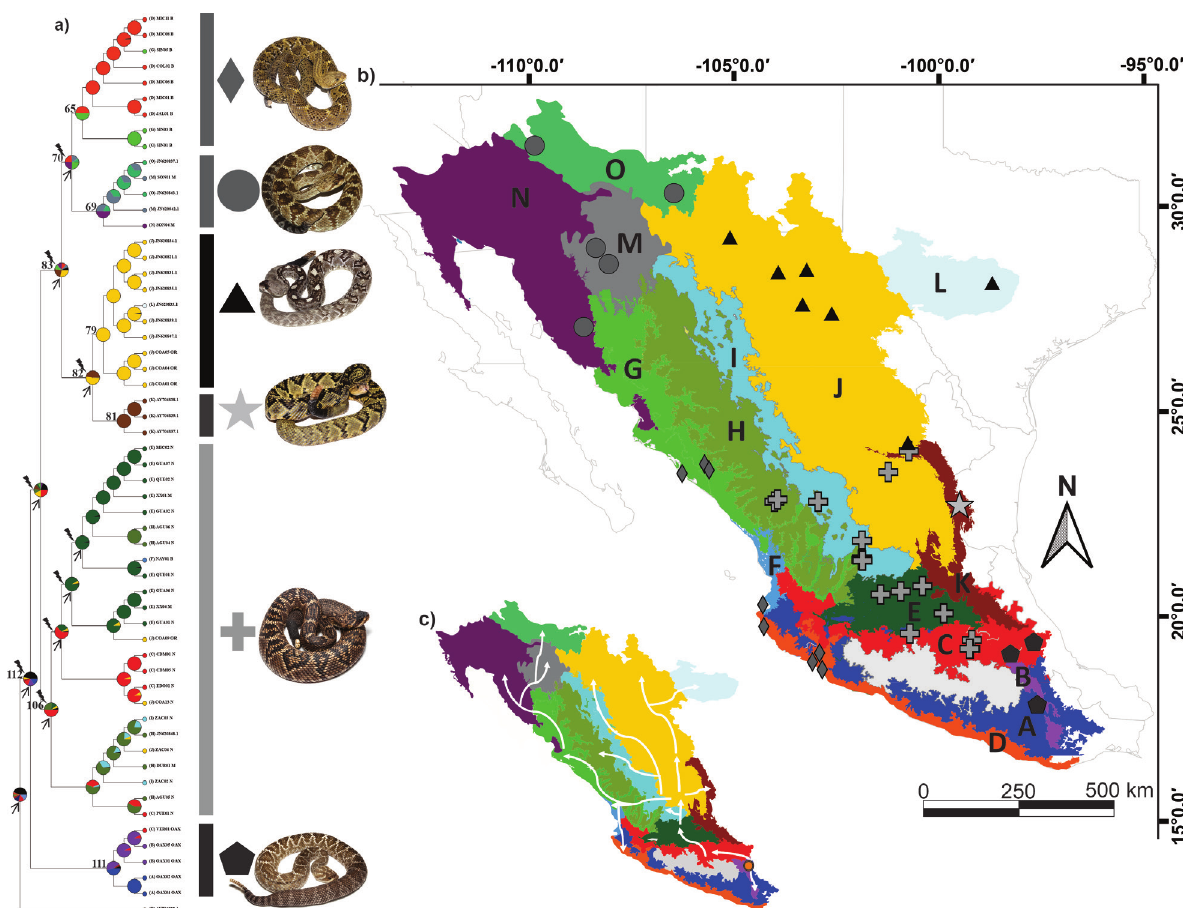
Figure 5. a. Ancestral area reconstruction based on the DIVA+J model from BioGeoBEARS. Pie charts at phylogeny nodes indi- cate the probability of the ancestral range occupied by that ancestor. Each color represents a reconstructed designated area, the black parts within the pies, indicated the areas with probabilities <5%. The arrows show the vicariance events and the rays the dispersal events. Rhombus ( C. basiliscus ), circle ( C. m. molossus ), triangle ( C. ornatus ), star ( C. totonacus ), cross ( C. m. nigrescens ), penta- gon ( C. m. oaxacus ); b. Fifteen North American Terrestrial Ecoregions-Level III considered for the area’s reconstruction; c. Hypo- thetical scenario explaining the biogeographical structure of the black-tailed rattlesnakes’ group. Photos by Eric Centenero-Alcalá and Sociedad Herpetológica del Noreste de México